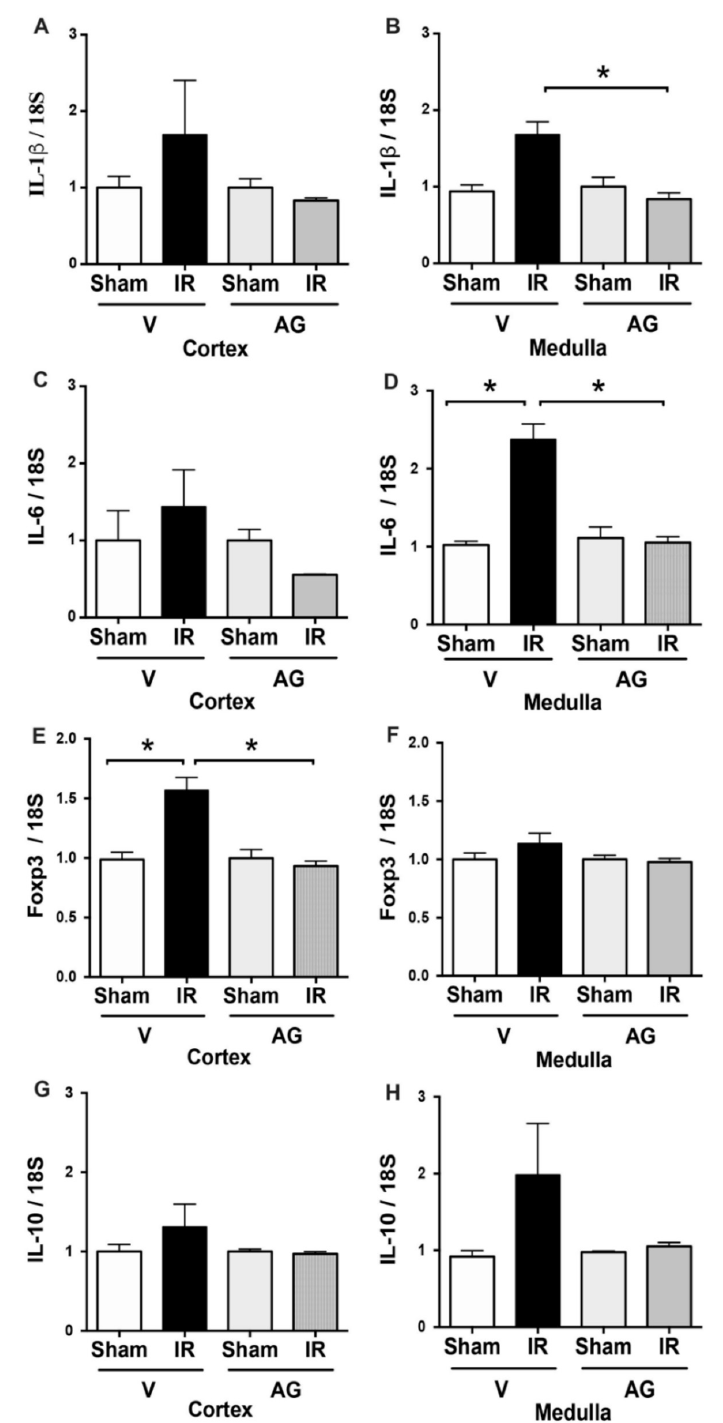
Figure 2. AG inhibited the IL-1 β , IL-6, Foxp3, and IL-10 mRNA upregulation observed during IR. BALB/c mice were treated with either vehicle or AG (50 mg/kg i.p) before sham or subjected to 30 min of ischemia and 48 h of reperfusion (IR). Cytokine expression was determined by qPCR in sham (n = 5), IR (n = 5), AG-sham (n = 6), and AG-IR (n = 6). ( A ) IL-1 β mRNA in the cortex. ( B ) IL-1 β mRNA in the medulla. ( C ) IL-6 mRNA in the cortex. ( D ) IL-6 mRNA in the medulla. ( E ) Foxp3 mRNA in the cortex. ( F ) Foxp3 mRNA in the medulla. ( G ) IL-10 mRNA in the cortex. ( H ) IL-10 mRNA in the medulla. The bar graphs represent mean ± SEM, and the data were analyzed using ANOVA and non-parametric Kruskal–Wallis test. * p <